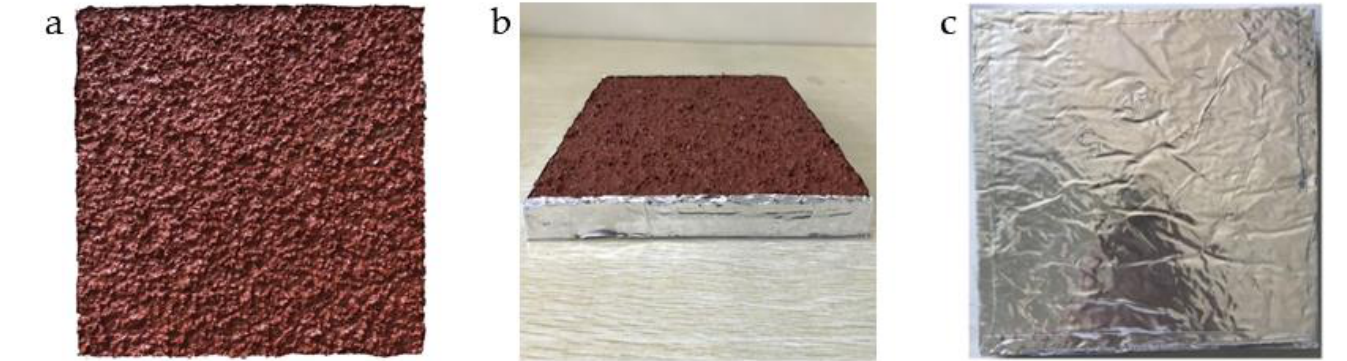
Figure 1. A PU plastic track sample after sealing and covering with aluminum foil. ( a ) Front, ( b ) side, and ( c ) back surfaces.